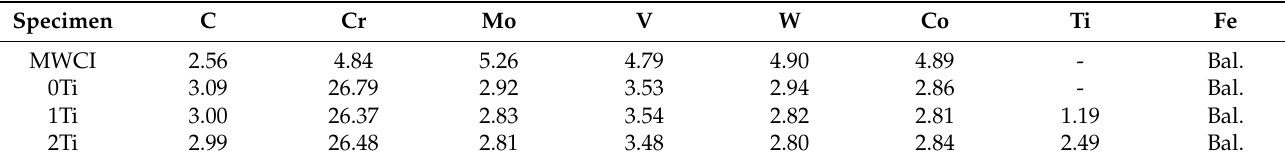
Table 1. Chemical composition of each specimen (wt.%).